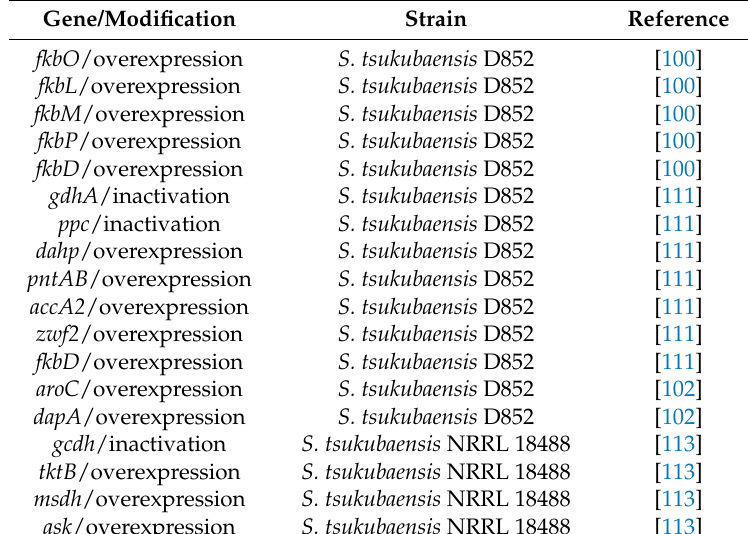
Table 2. Genetic modifications predicted through metabolic modelling in S. tsukubaensis to improve tacrolimus production. The target gene, type of modification, strain and bibliographic reference are